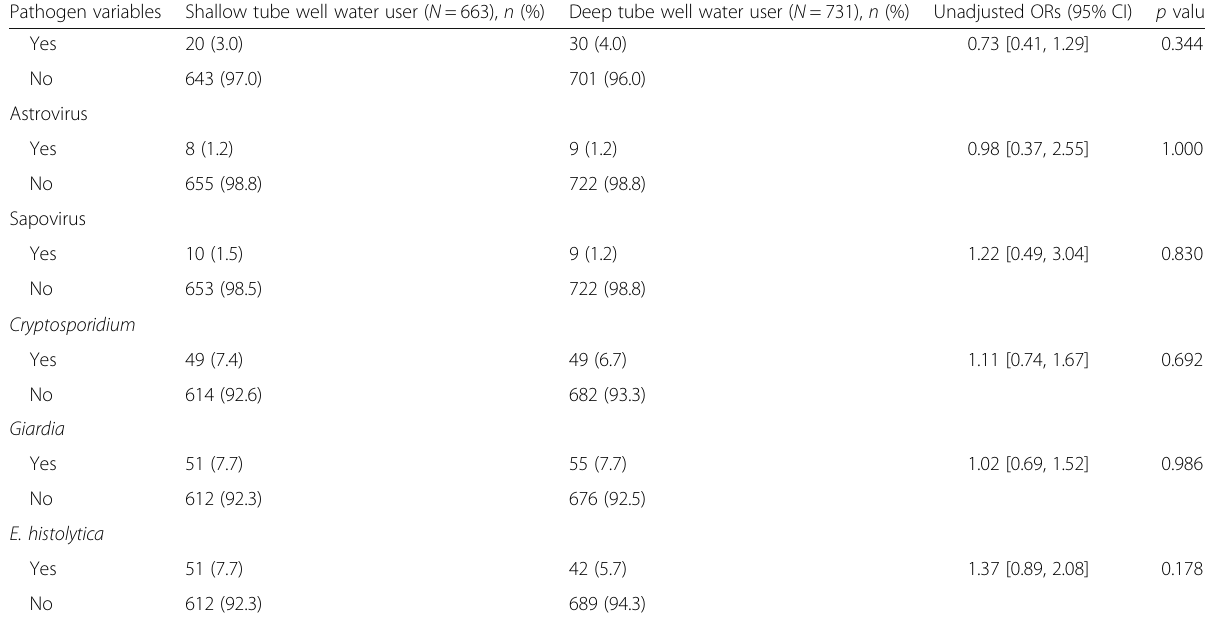
Table 3 Pathogen distribution among under-5 moderate-to-severe diarrheal children from the two types of tube well water user families (Continued)